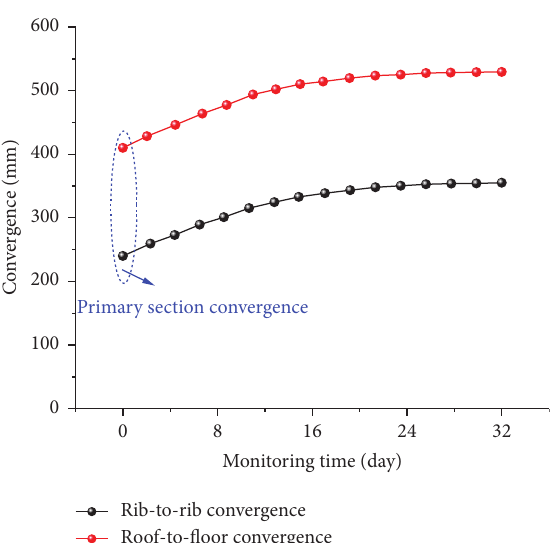
Figure 14: Field monitoring diagram of the LODM deformation of 5202 working